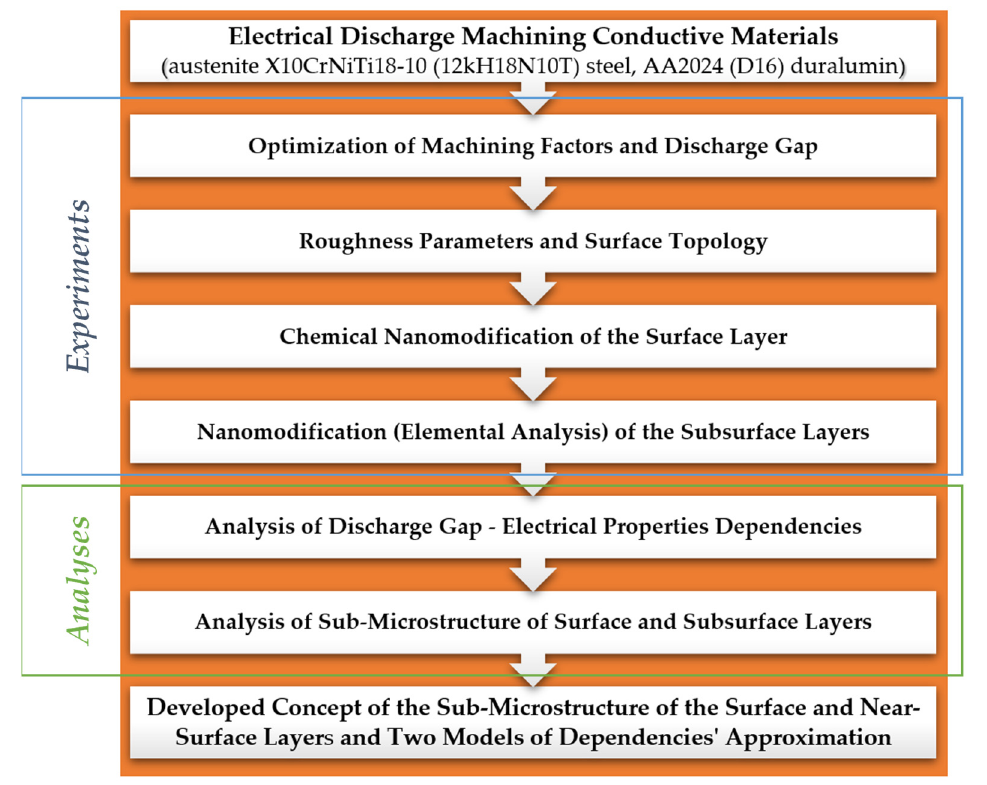
Figure 1. Flow chart of the stepwise procedure of experiments and analyses carried out.